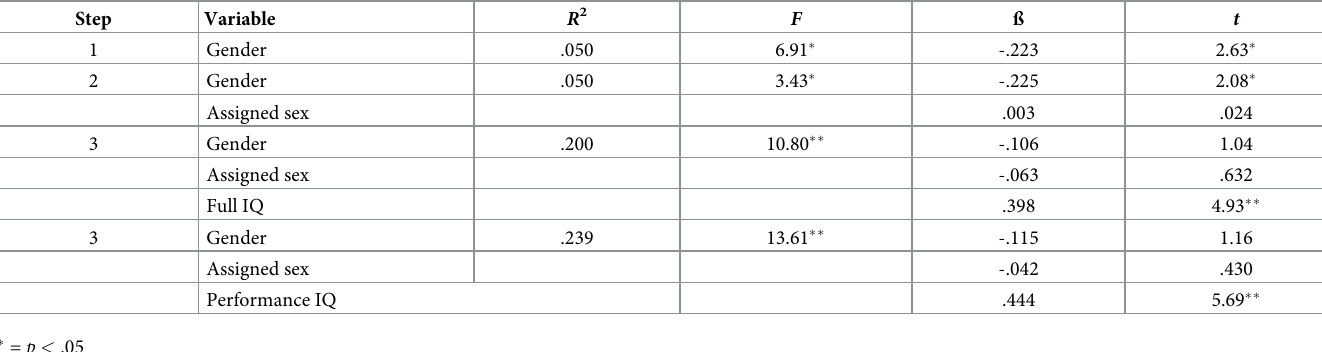
Table 2. Stepwise multiple-regression analysis of percent correct averaged across hemisphere in mental-rotation task.